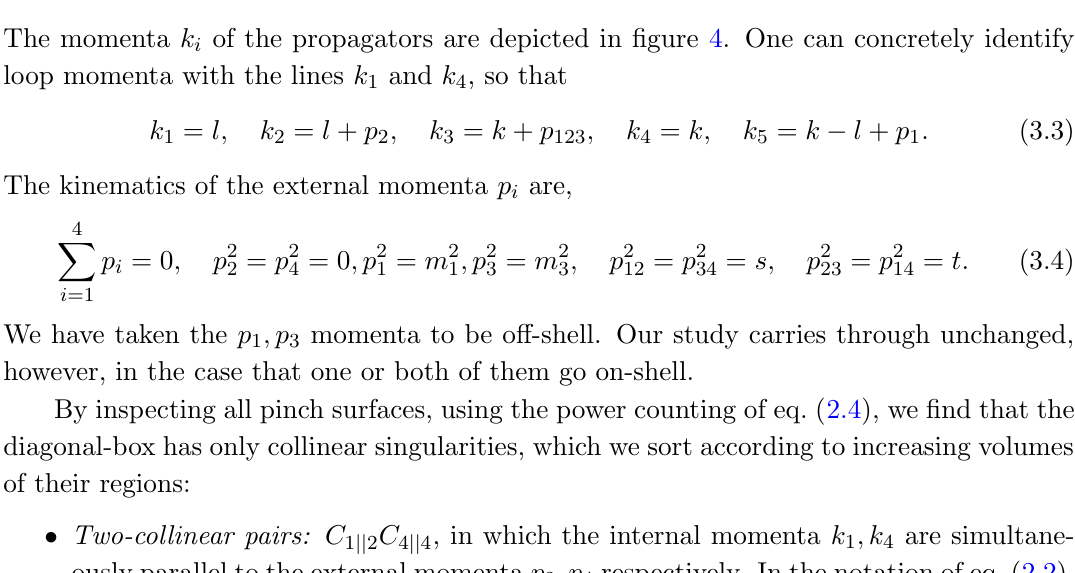
Figure 4 . The two-loop